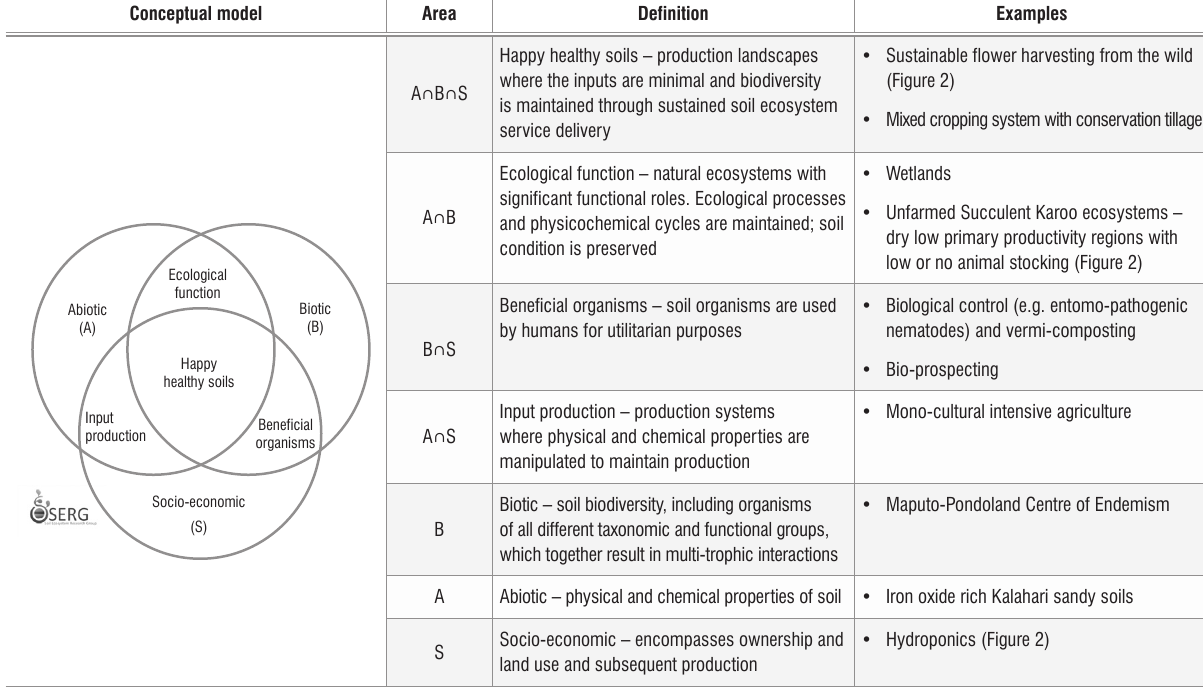
Hydroponics Nature reserves in the Succulent Karoo Sustainable harvesting of wild flowers